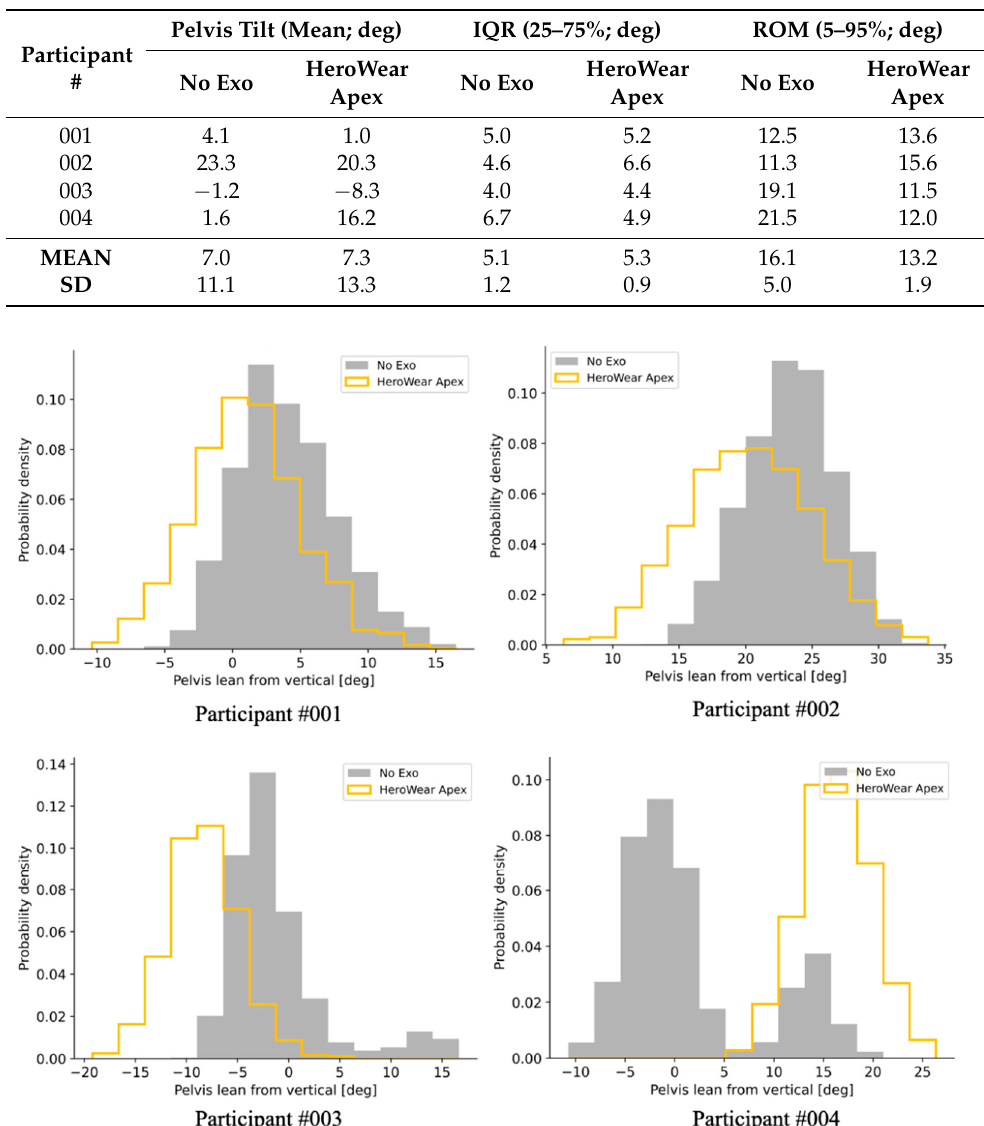
Table 3. Pelvis tilt (deg) for pushing the unloaded gondola downhill.